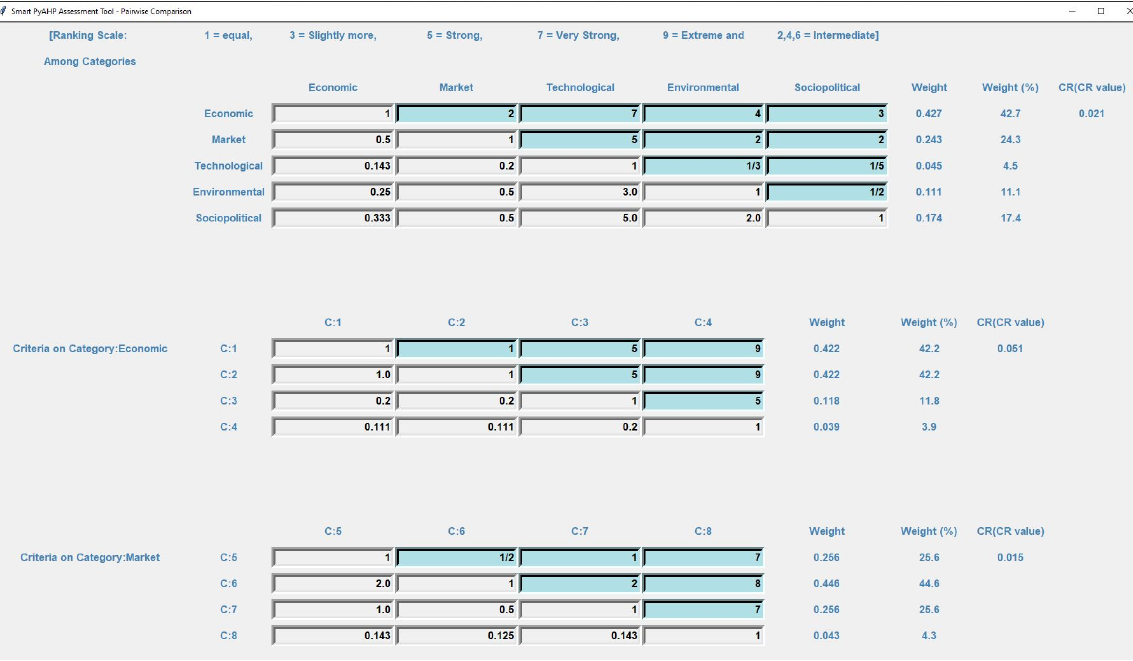
Figure 7. Pair-wise comparisons inserted in the generated matrices.